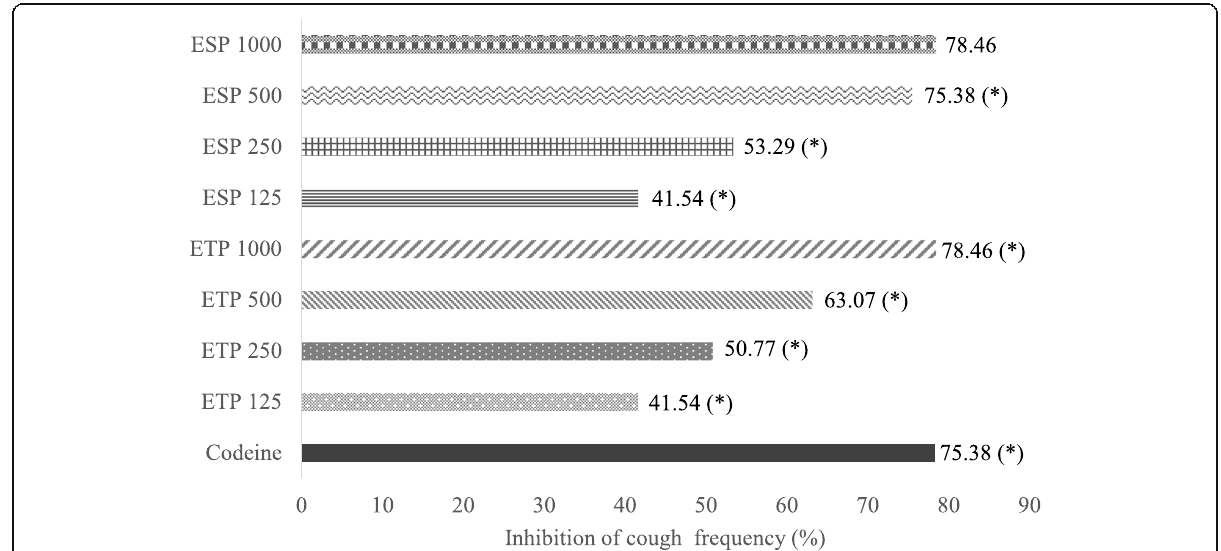
Fig. 1 Antitussive activity of ethanol extracts of S. jujuyensis and T. fiebrigi propolis. Values are expressed as mean ± SE ( n = 6). * p < 0.05 compared with the control group